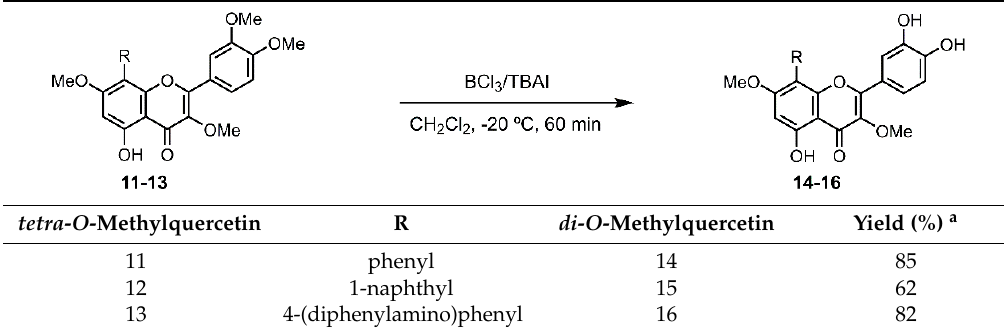
Table 2. Synthesis of 3,7- di - O -methylquercetins ( 14 – 16 ).